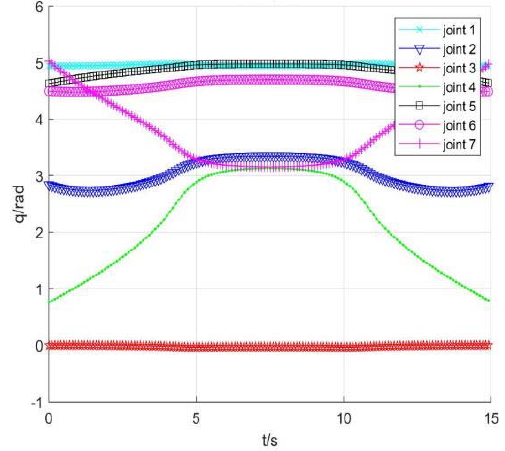
Figure 13. Position change of robot joints.